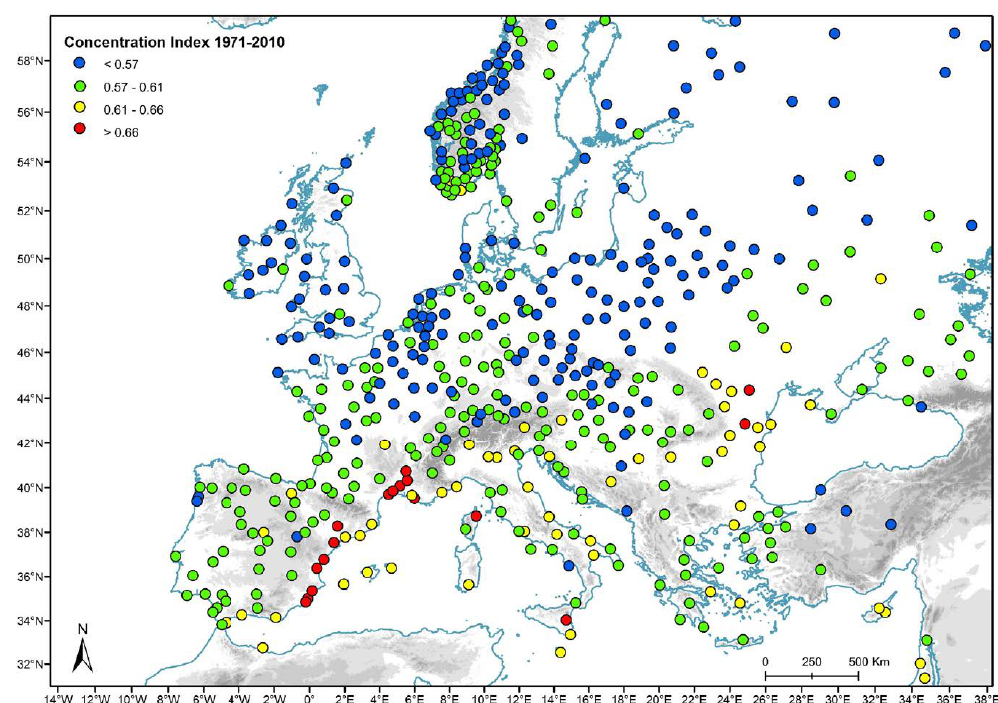
Fig. 4. Winter CI values distribution. Each colour corresponds to a different interval: CI values 0.56 or lower (blue dots), between 0.57 and 0.61 (green dots), between 0.62 and 0.66 (yellow dots), and 0.67 or higher (red dots).